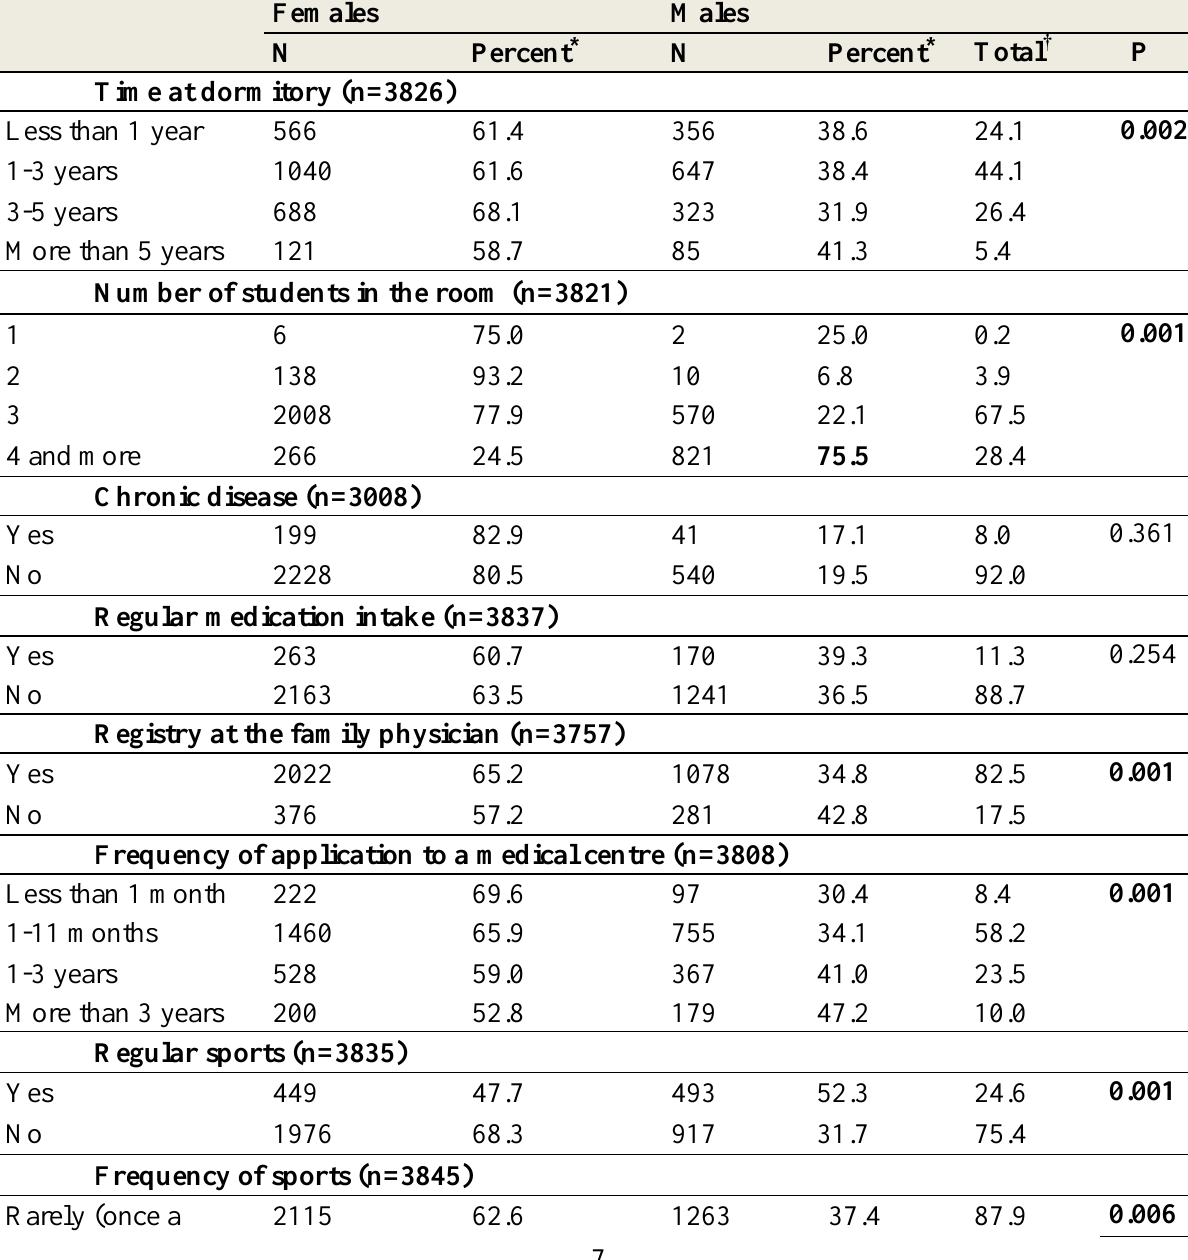
Table 3. Distribution of certain characteristics and habits of students by gender